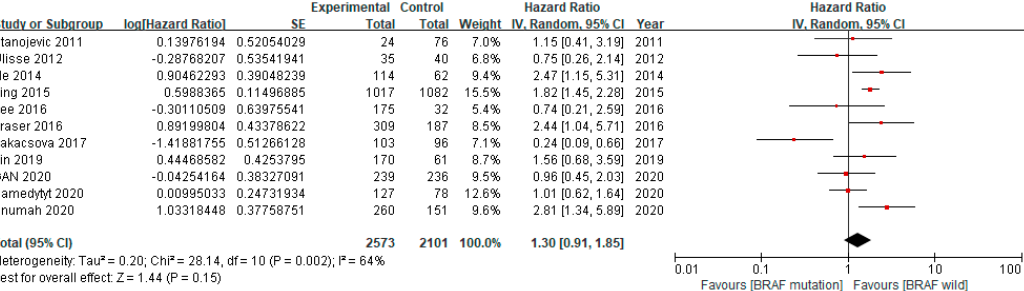
Figure 2. Forest plot of the included studies analyzing the recurrence rates between the patients with the BRAF V600E mutation and those with wild-type BRAF.